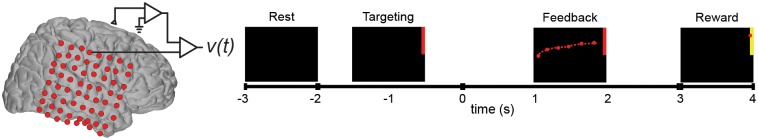
BCI task overview.Overview depicts the spatial scale of the ECoG grids, as well as the phases and timing of the BCI task. Subjects were presented with a target occupying either the upper (up target; depicted) or lower half (down target) of the right-most edge of the screen and had 3 sec to control the vertical position of the feedback cursor such that it ended the trial in the target area.